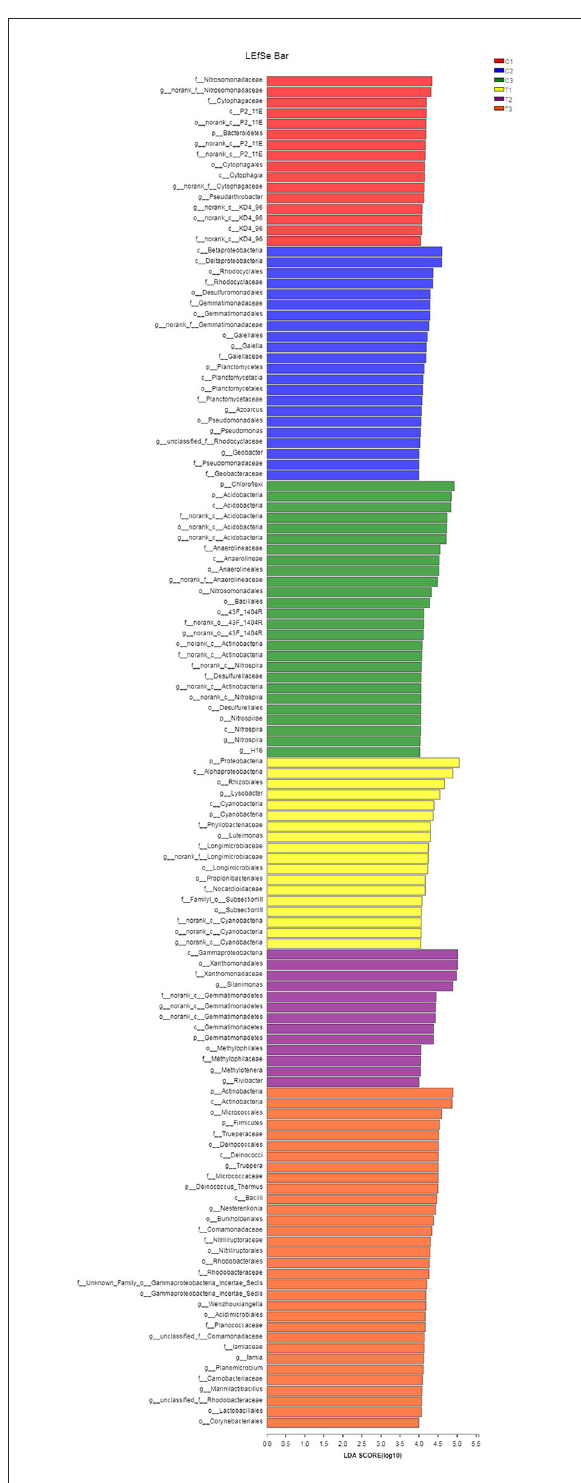
FIGURE11 LEfSe was used to discriminate the microbial communities of all soil samples. LDA discriminant bar charts were used to count microbial taxa that differed significantly in all groups. All data in the experiment represent three independent